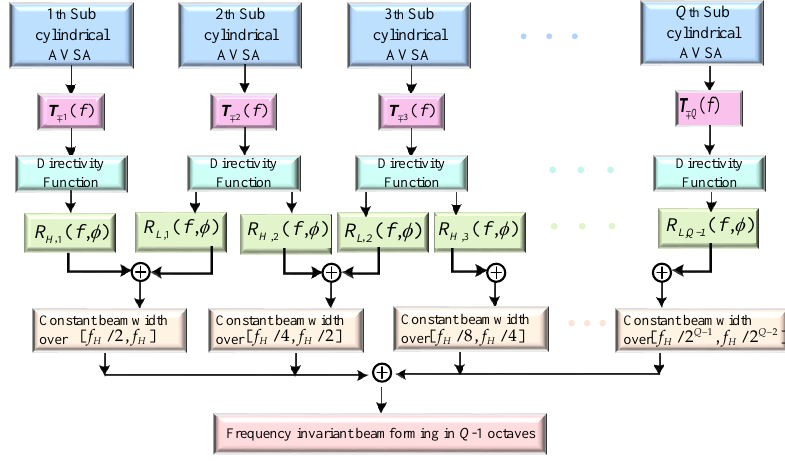
Figure 6. Geometry of the frequency invariant beamforming in multiple